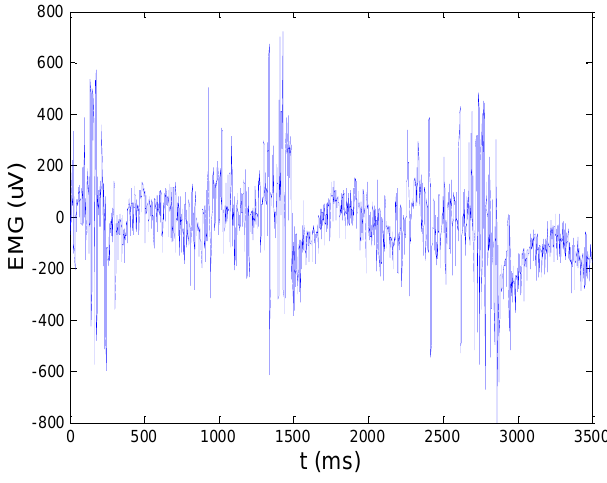
Figure 15. EMG signal (shown in Figure 13) filtered by wavelet method.